Question: In a single sentence, describe what this figure presents.
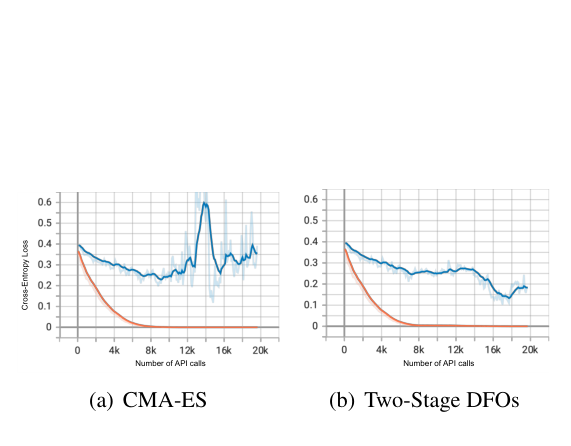
Answer: Comparison of original CMA-ES and Two- stage DFOs on Yelp dataset.